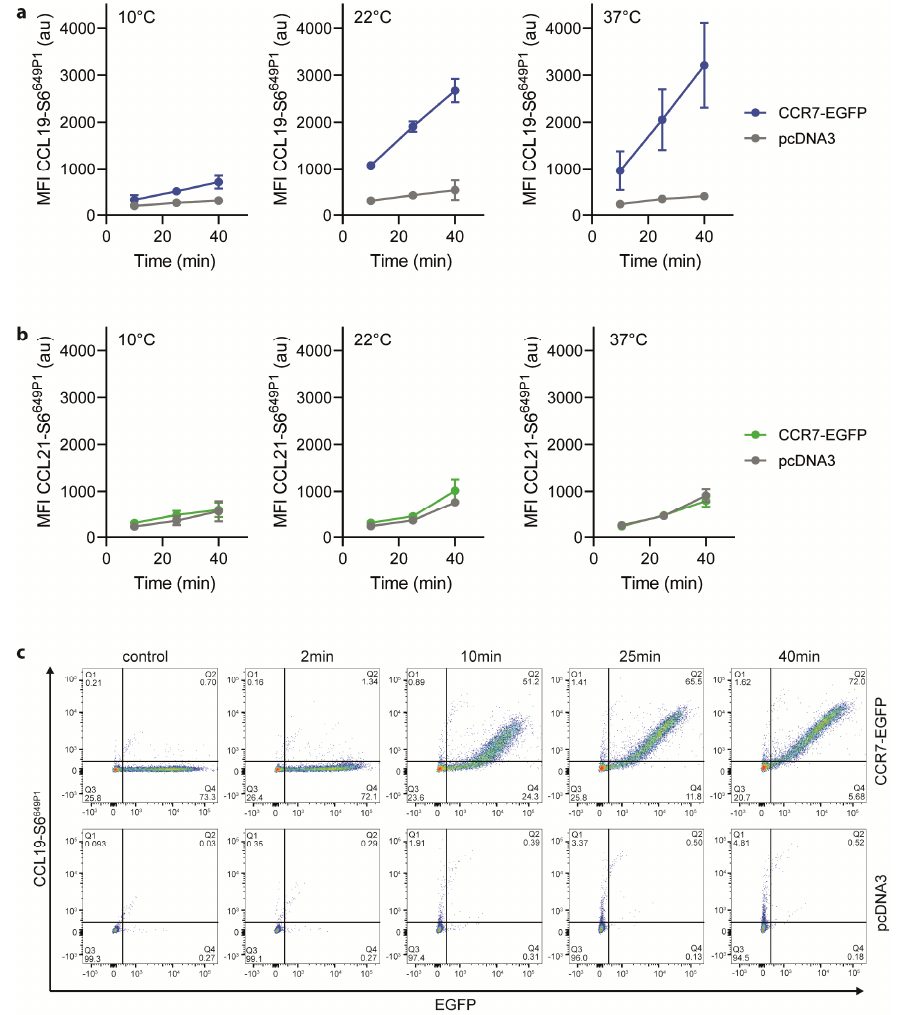
Figure 4. CCL19-S6 649P1 readily and specifically binds to CCR7-expressing cells. ( a , b ) HeLa cells transiently transfected with CCR7-EGFP or its vector control (pcDNA3) were incubated at indicated temperature and time periods with 25 nM of CCL19-S6 649P1 ( a ), or CCL21-S6 649P1 ( b ). Cell associated, chemokine-derived mean fluorescence intensities (MFI) were recorded by flow cytometry. Mean values ± SD of three independent experiments are shown. ( c ) HeLa cells transiently transfected with CCR7-EGFP or its vector control (pcDNA3) were incubated at 22 °C with 25 nM of CCL19-S6 649P1 for indicated time periods. Representative dot plots of one out of three experiments depicting CCL19-S6 649P1 binding to CCR7-EGFP expressing and pcDNA3 vector control transfected cells.